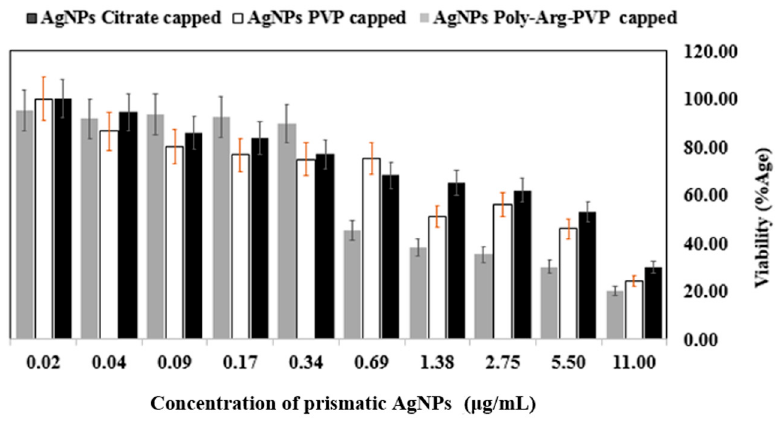
Figure 13. Cell viability of HeLa cell lines after treatment with spherical AgNPs coated with citrate, PVP and poly-Arg-PVP.